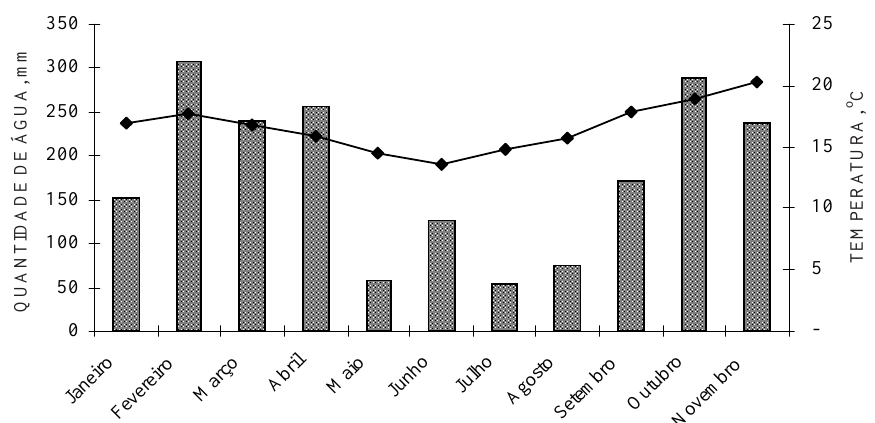
Figura 1. Quantidade mensal de água recebida pela cultura (barras) e temperatura média mensal (linha) no período de janeiro a novembro de 1996. (Fonte: Departamento de Ciências Exatas,